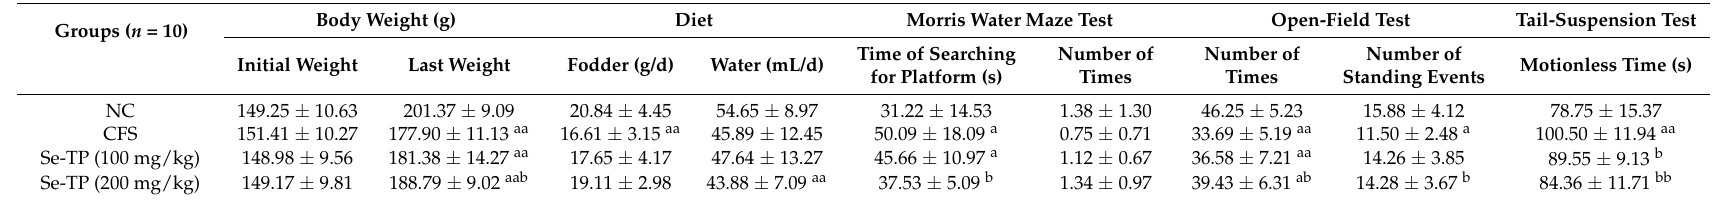
Table 1. Evaluation results of rats in CFS